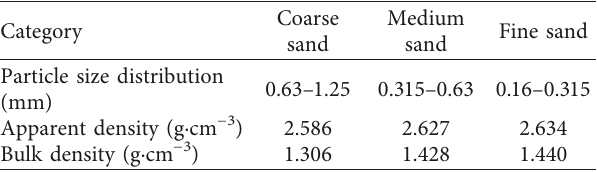
Table 3: The size distribution of quartz